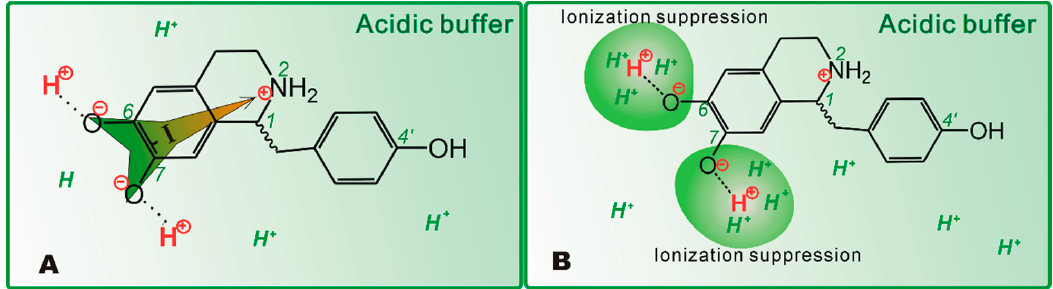
Figure 6. The two approaches for the pH effect towards antioxidant higenamine: ( A ). withdrawing inductive effect (-I) reduced the electron-transfer (ET) potential of benzene-ring; ( B ). suppressed ionization of phenolic-OH by solution H + .